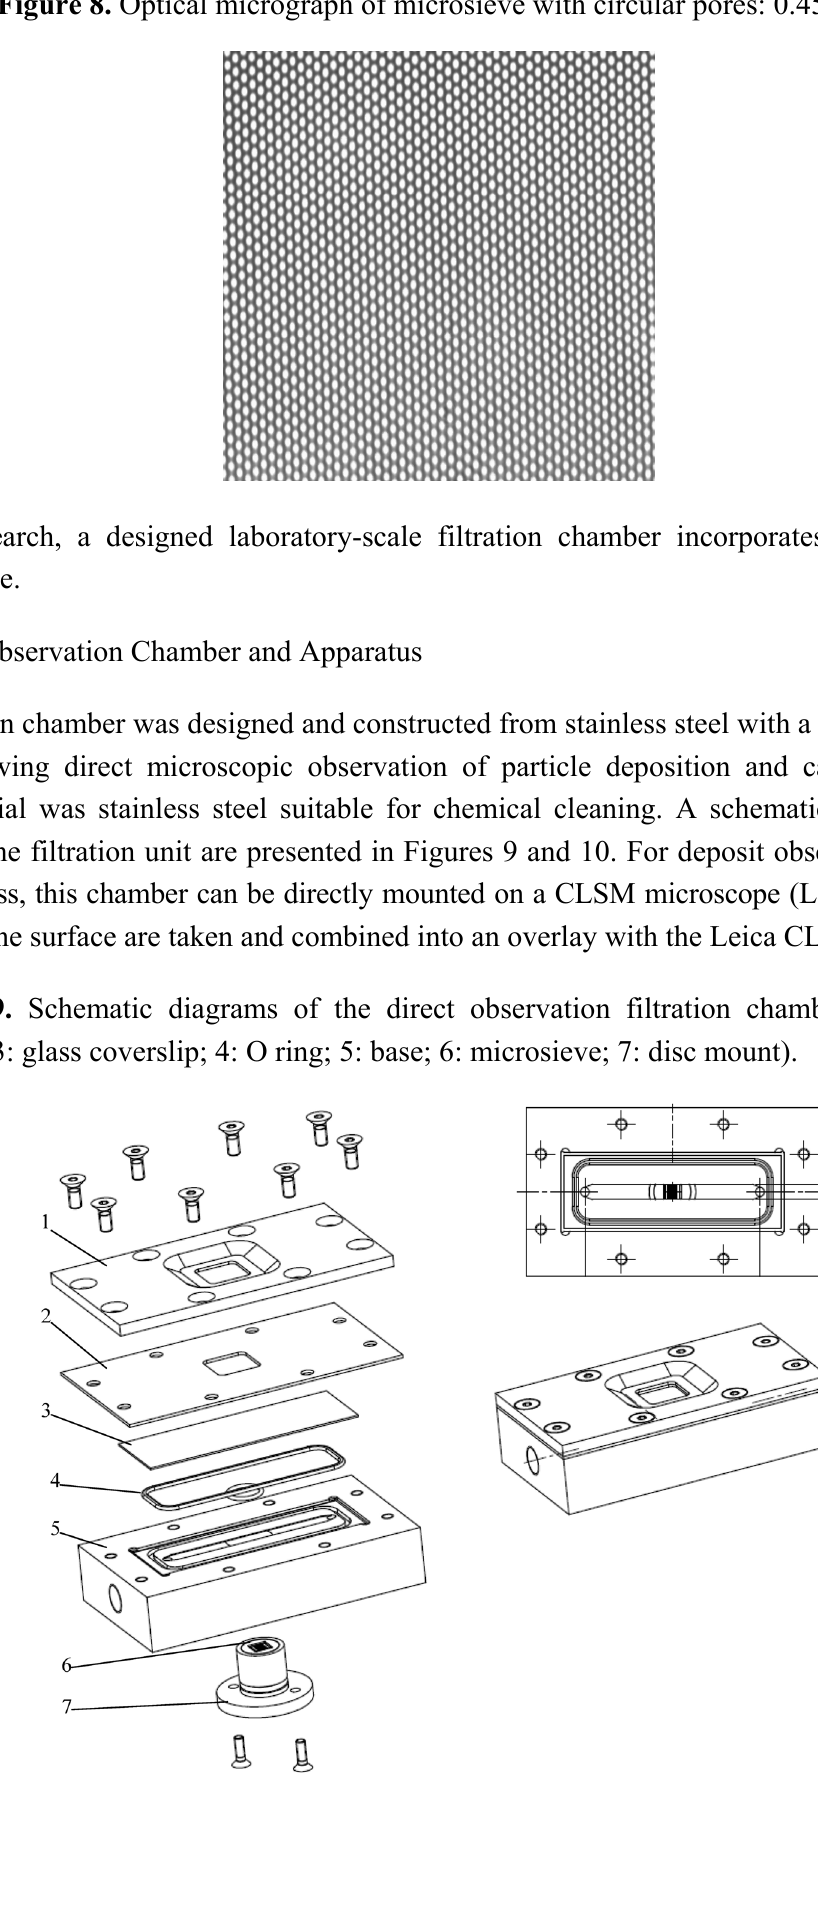
Figure 8. Optical micrograph of microsieve with circular pores: 0.45 µm.